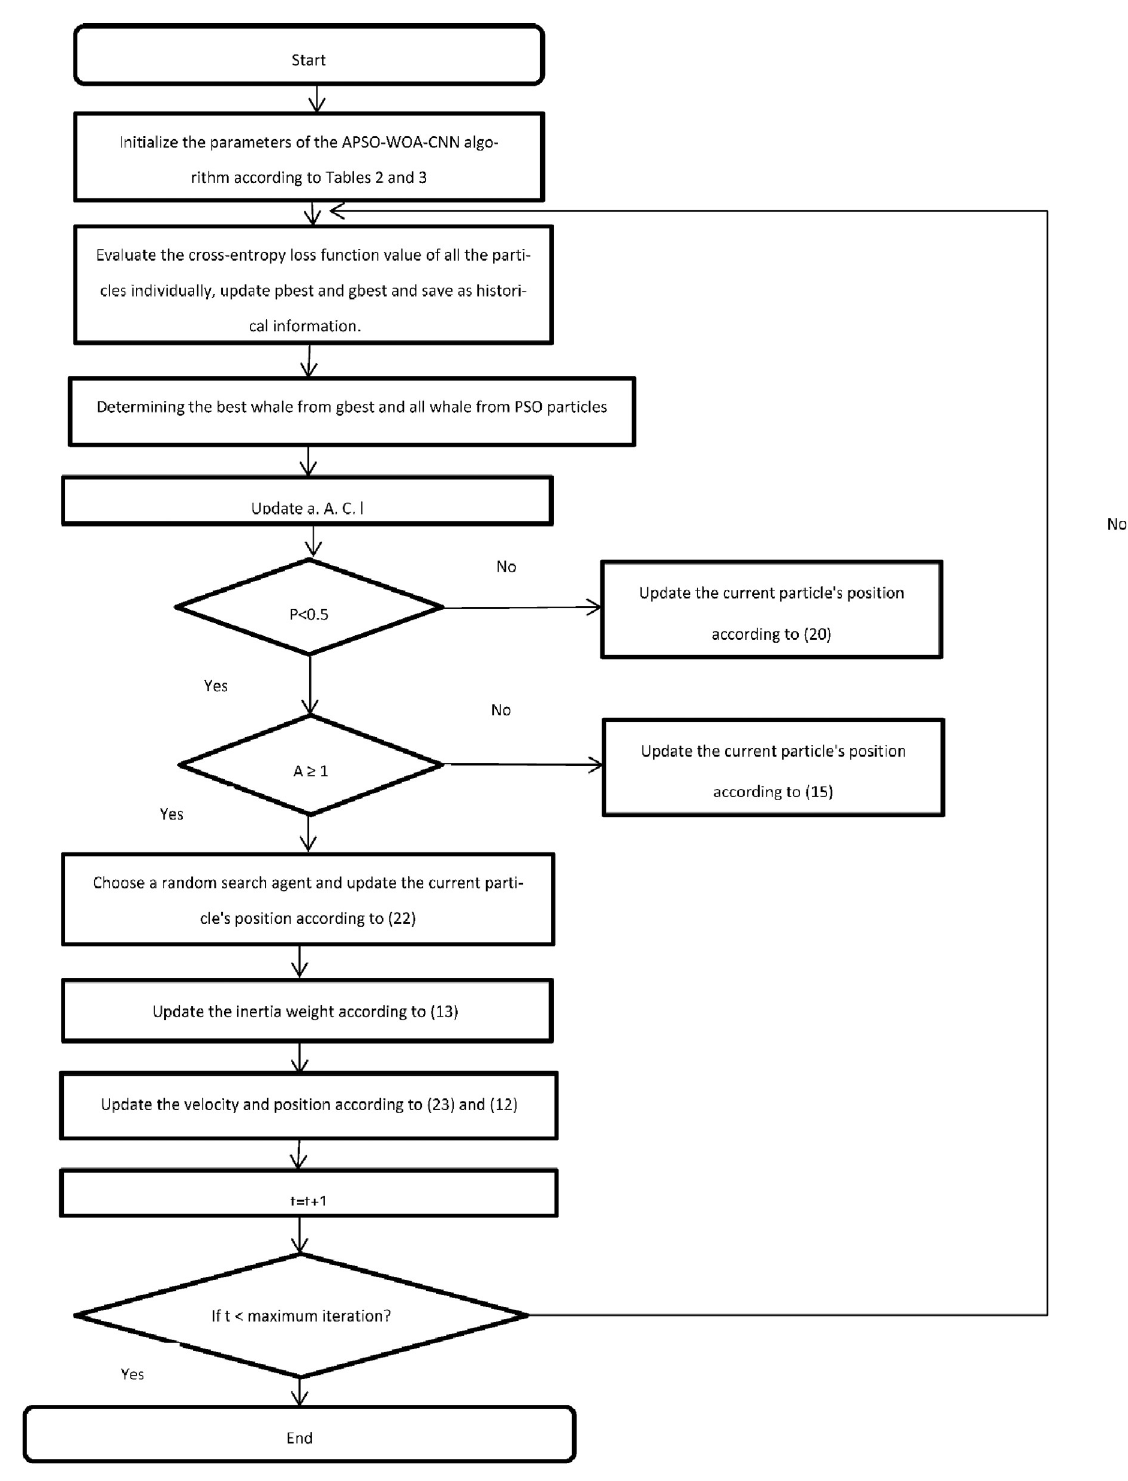
Fig 3. The APSO-WOA-CNN algorithm flowchart.